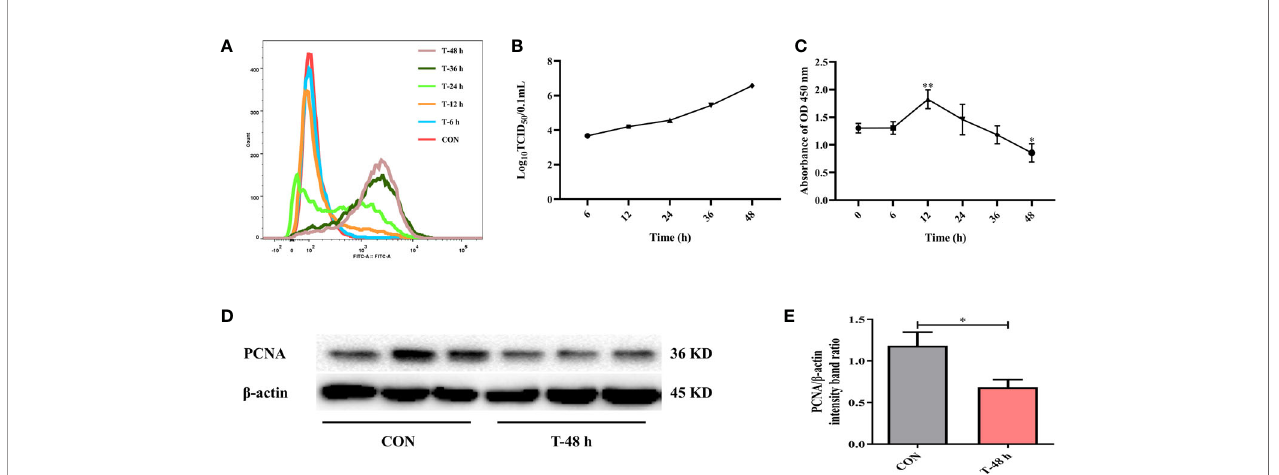
FIGURE 1 | TGEV infection in IPEC-J2 cells. (A) The contents of TGEV at 0, 6, 12, 24, 36, and 48 hpi were analyzed via fl ow cytometry. (B) The viral titers of TGEV infected IPEC-J2 cells at 6, 12, 24, 36, and 48 hpi. (C) CCK-8 assay was used to detect the cell proliferation after TGEV infection at 6, 12, 24, 36, and 48 hpi. Data express the mean ± SEM (n = 3). (D) The PCNA level was detected by western blot. (E) Quantitation of bands to demonstrate the protein level of PCNA. Data express the mean ± SEM (n = 3). The symbol * indicates statistically signi fi cant differences ( P < 0.05), and the symbol ** indicates statistically very signi fi cant differences ( P <